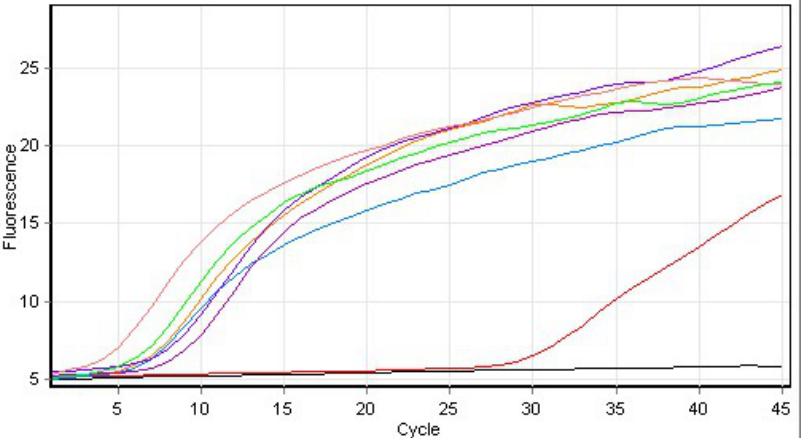
Figure A1. Exemplary visualization of recorded amplification curves. Here: amplification with samples containing DTU DNA at high concentrations according to the RealStar assay. Positive control amplification can be seen at cycle threshold 29.